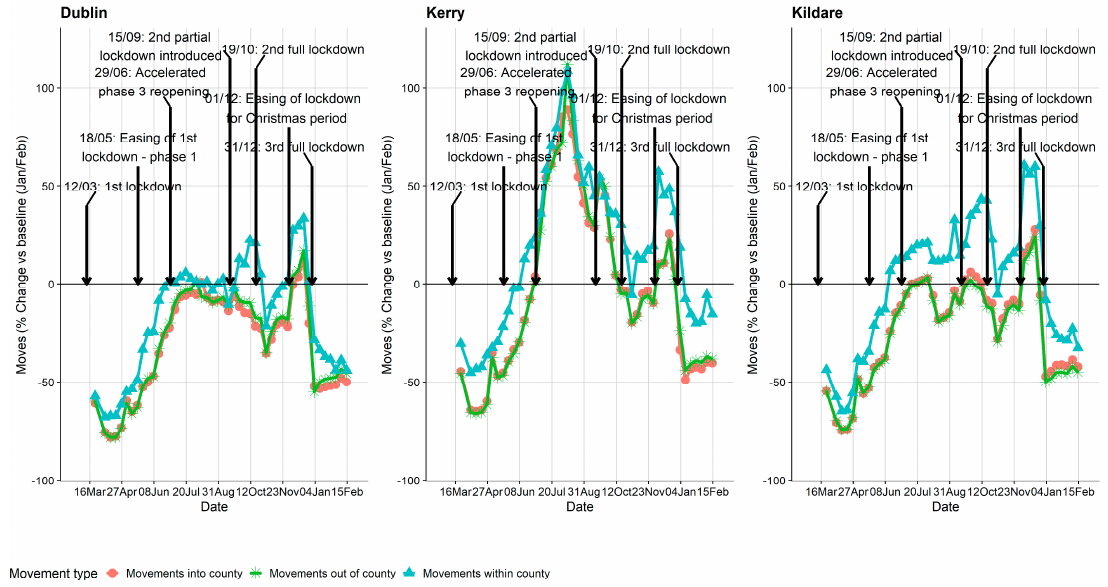
Figure 6. Mobility plot—percentage change in the number of journeys into, out of and within counties Dublin, Kerry and Kildare compared to their baseline figures (January/February 2020). Plots of all 26 Irish counties are included in the supplementary material.